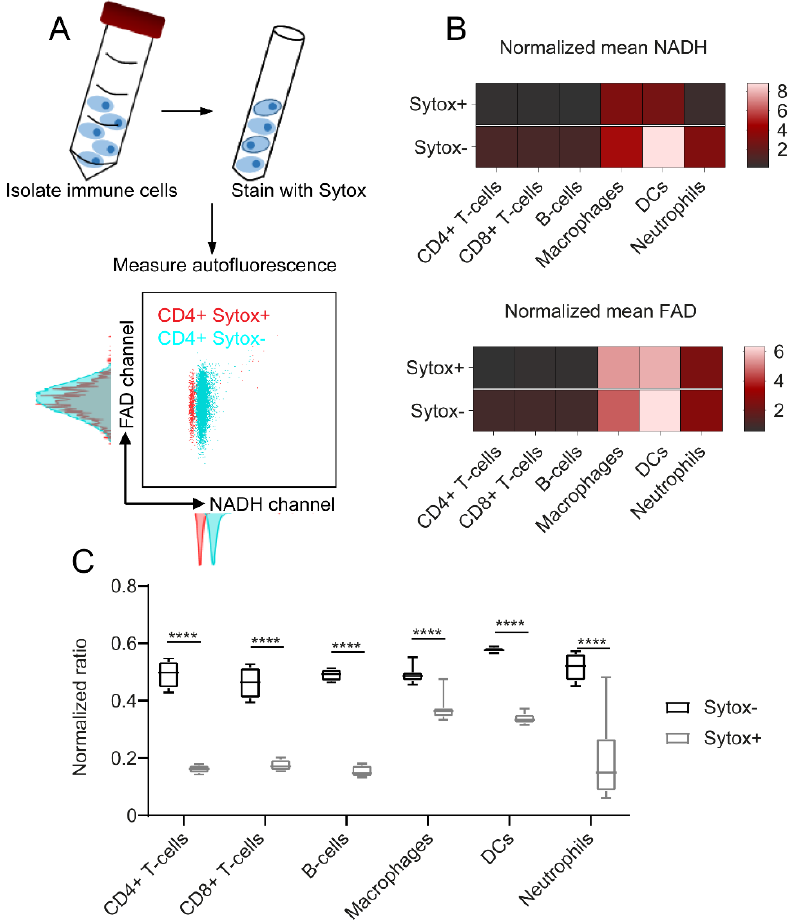
Figure 3. NADH autofluorescence decrease upon cell death as shown by flow cytometry. ( A ) To identify dead cells, the samples were stained with Sytox Red after isolation. Autofluorescence signals were measured using flow cytometry. ( B ) NADH and FAD signals of dead (Sytox+) and alive (Sytox − ) cells, illustrated in a heat map. ( C ) Redox ratios calculated as R = NADH/(NADH + FAD). For statistical analysis, two- way ANOVA with Sidak’s multiple comparisons test was used (**** p < 0.0001). At least four samples per group were analysed. Each sample reflects either cells isolated from one mouse (CD4+ T cells, CD8+ T cells, B cells, neutrophils) or cells cultured in one culture dish (macrophages, dendritic cells).